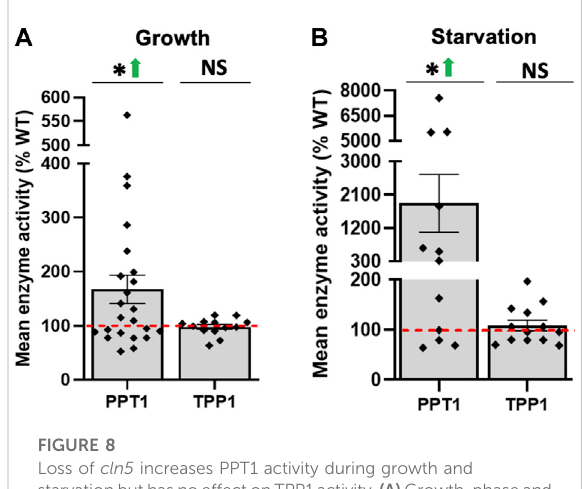
FIGURE 8 Loss of cln5 increases PPT1 activity during growth and starvationbuthasnoeffectonTPP1activity. (A) Growth-phaseand (B) 4-hour starved WT and cln5 - cells were lysed PPT1 and TPP1 activity in whole cell (WC) lysates were subtracted from the blank solution and activities in cln5 -de fi cient lysates were standardized against the activities in WT samples. Data presented as mean enzyme activity (% WT) ± SEM (n ≥ 12). * p < 0.05 (one sample t -test). NS – not signi fi cant.